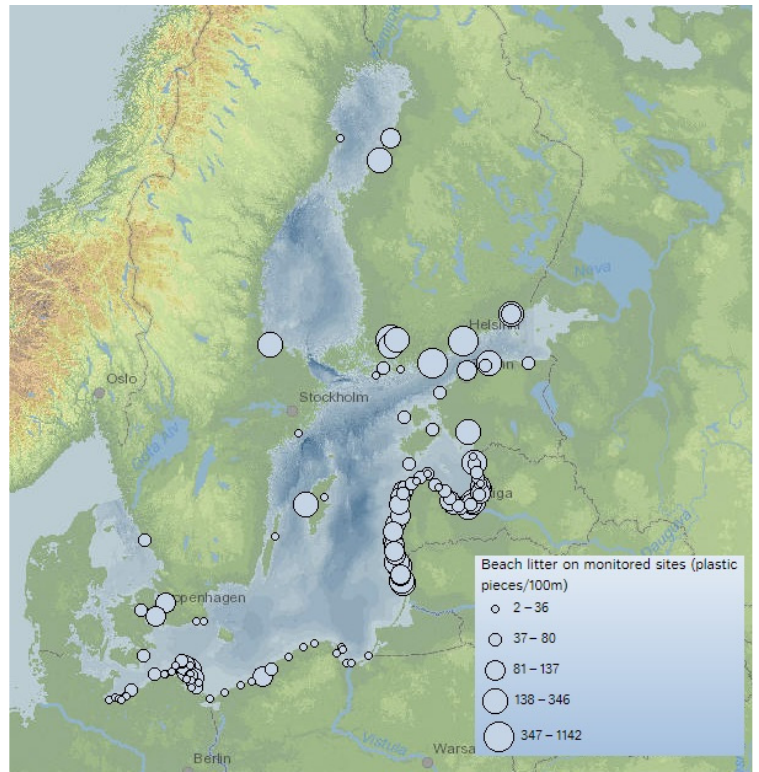
Figure 2. Marine litter monitored on beaches of the Baltic Sea, based on HELCOM Map and Data Service, 2022 [5].